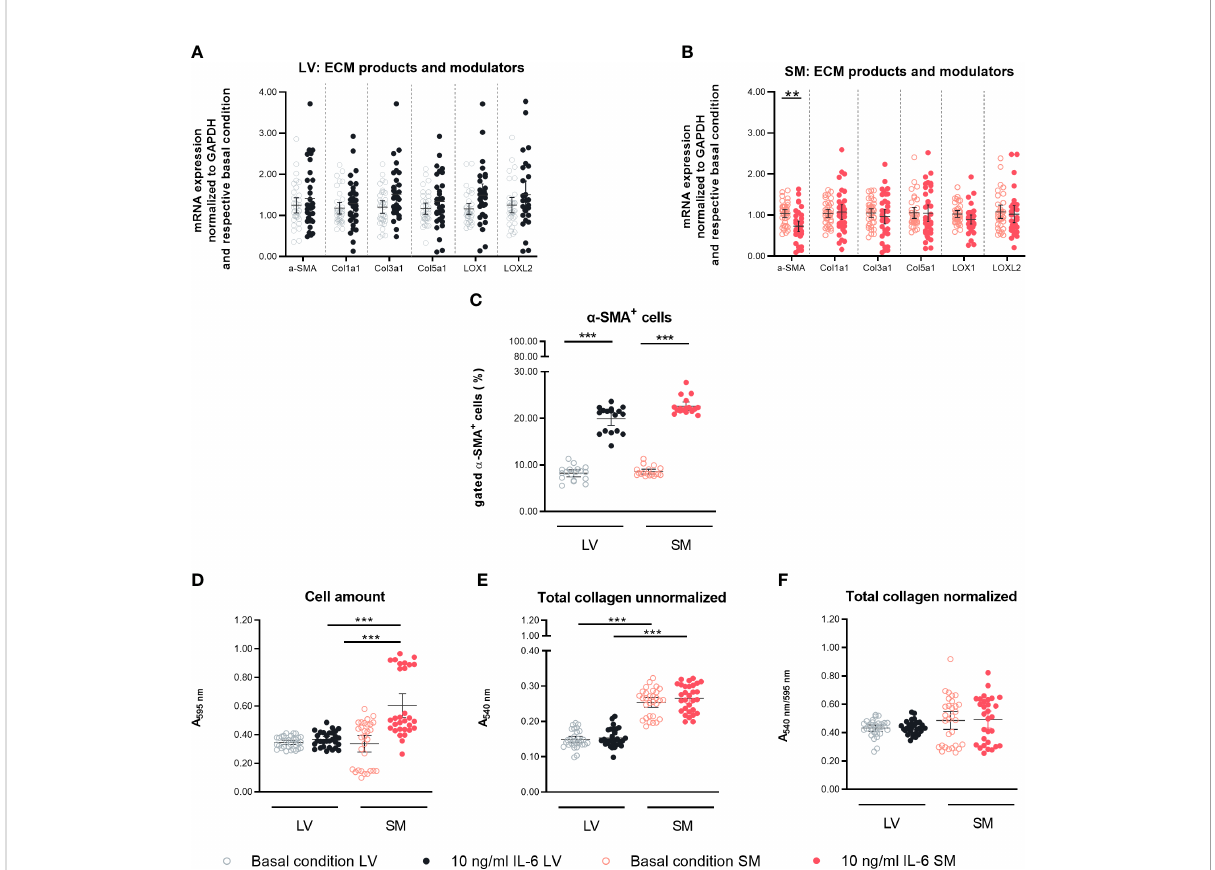
FIGURE 2 IL-6 stimulation leads to differential regulation of a -SMA in left ventricle (LV)- and skeletal muscle (SM)-derived fi broblasts. mRNA expression of a -SMA, ECM components, and modulators (Col1a1, Col3a1, Col5a1, LOX, and LOXL2) normalized to GAPDH and the respective basal condition of (A) LV-derived (black) and (B) SM-derived (red) fi broblasts after 24-h culture with basal medium without IL-6 (basal condition; bright hollow circle) or with 10 ng/ml of IL-6 (dark fi lled circle); n = 36, N = 6, Mann – Whitney/Welch ’ s test. (C) Percentage of gated a -SMA + cells ( fl ow cytometry data) of LV-derived (black) and SM-derived (red) fi broblasts after 24-h culture with basal medium without IL-6 (basal condition; bright hollow circle) or with 10 ng/ml of IL-6 (dark fi lled circle); n = 18, N = 3, Kruskal – Wallis/one-way ANOVA. (D) Cell number assessed via Crystal Violet assay and absorption at 595 nm from LV-derived (black) and SM-derived (red) fi broblasts after 24-h culture with basal medium without IL-6 (basal condition; bright hollow circle) or with 10 ng/ml of IL-6 (dark fi lled circle). Total collagen content of LV-derived (black) and SM- derived (red) fi broblasts after 24-h culture with basal medium without IL-6 (basal condition; bright hollow circle) or with 10 ng/ml of IL-6 (dark fi lled circle) measured via Sirius Red assay and absorption at 540 nm (E) unnormalized and (F) normalized to cell number (Crystal Violet assay data); n = 30, N = 3, Kruskal – Wallis/one-way ANOVA; all data are presented as mean ± 95% CI and tested with post-hoc Benjamini – Hochberg correction; adjusted p-values: **p < 0.01, ***p <